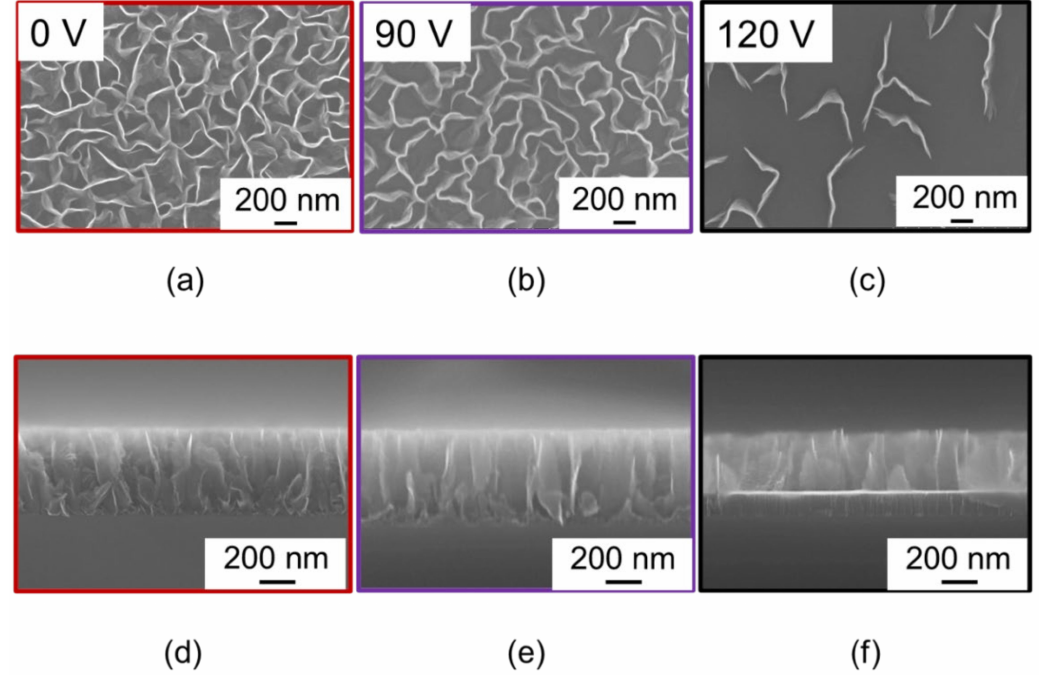
Figure 1. ( a – c ) Top-view and ( d – f ) cross-sectional-view SEM images of carbon nanowalls (CNWs) synthesized on Si at V in of ( a , d ) 0, ( b , e ) 90, and ( c , f ) 120